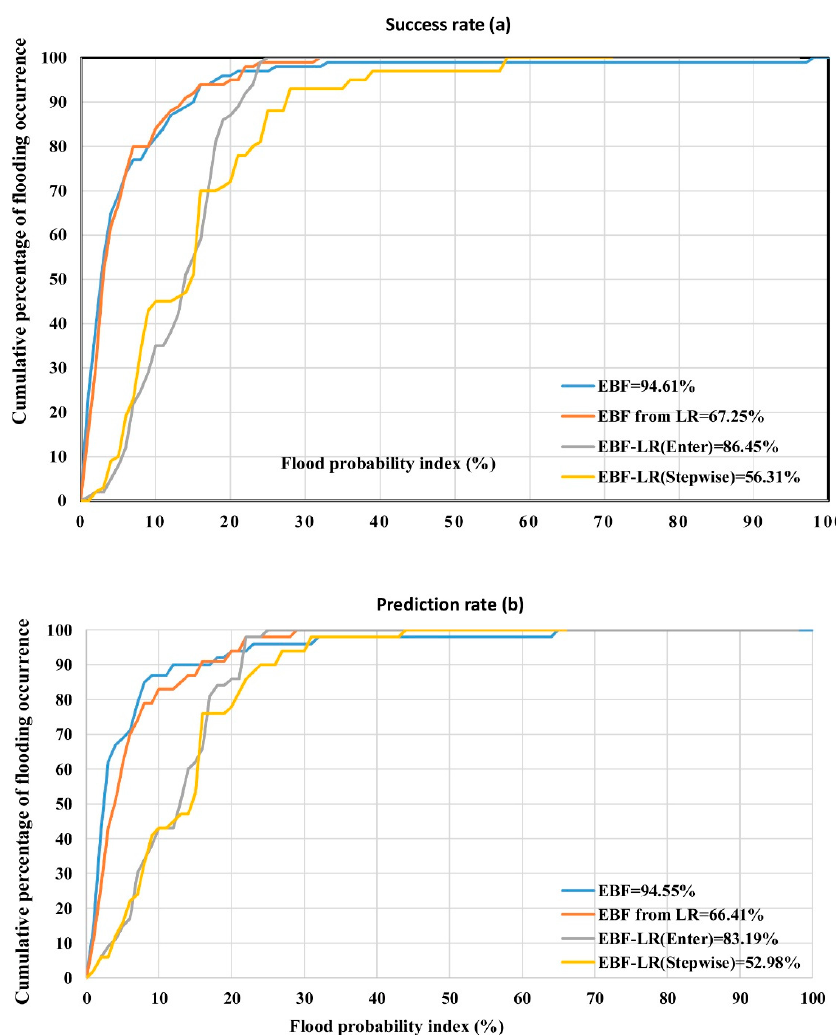
Remote Sens. 2019 , 11 , x FOR PEER REVIEW 19 of 27